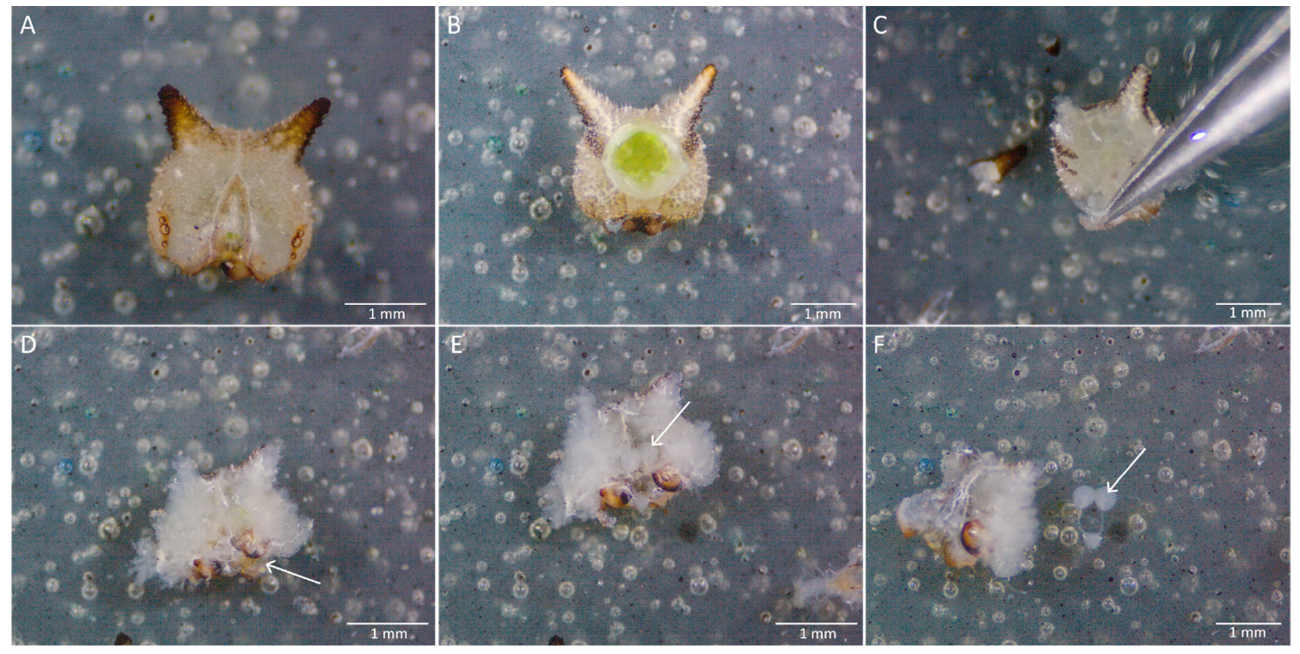
Figure 6. Dissection of the larval brain. ( A ) The head is cut out of the caterpillar body with a scalpel. ( B ) The head is turned face down for an easier dissection. ( C ) Pieces of cuticle are removed piece by piece around the head tissue. ( D ) The mandibles are left attached to the head tissue (arrow), as removing them might damage the brain ( E ). Gently pulling the head tissue on the right and left will create an opening, which exposes the brain (arrow). ( F ) The brain (arrow) attached to the gnathal ganglion (white mass below) can be gently pulled out after removing the pieces of head tissue around it and picked up with a pipette for further downstream experiments.